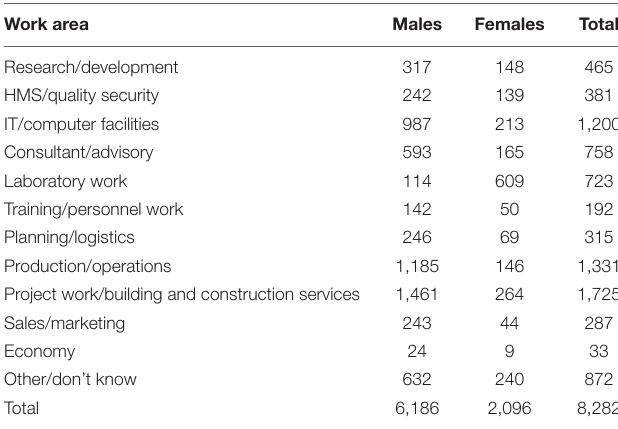
TABLE 1 | Gender distribution according to work